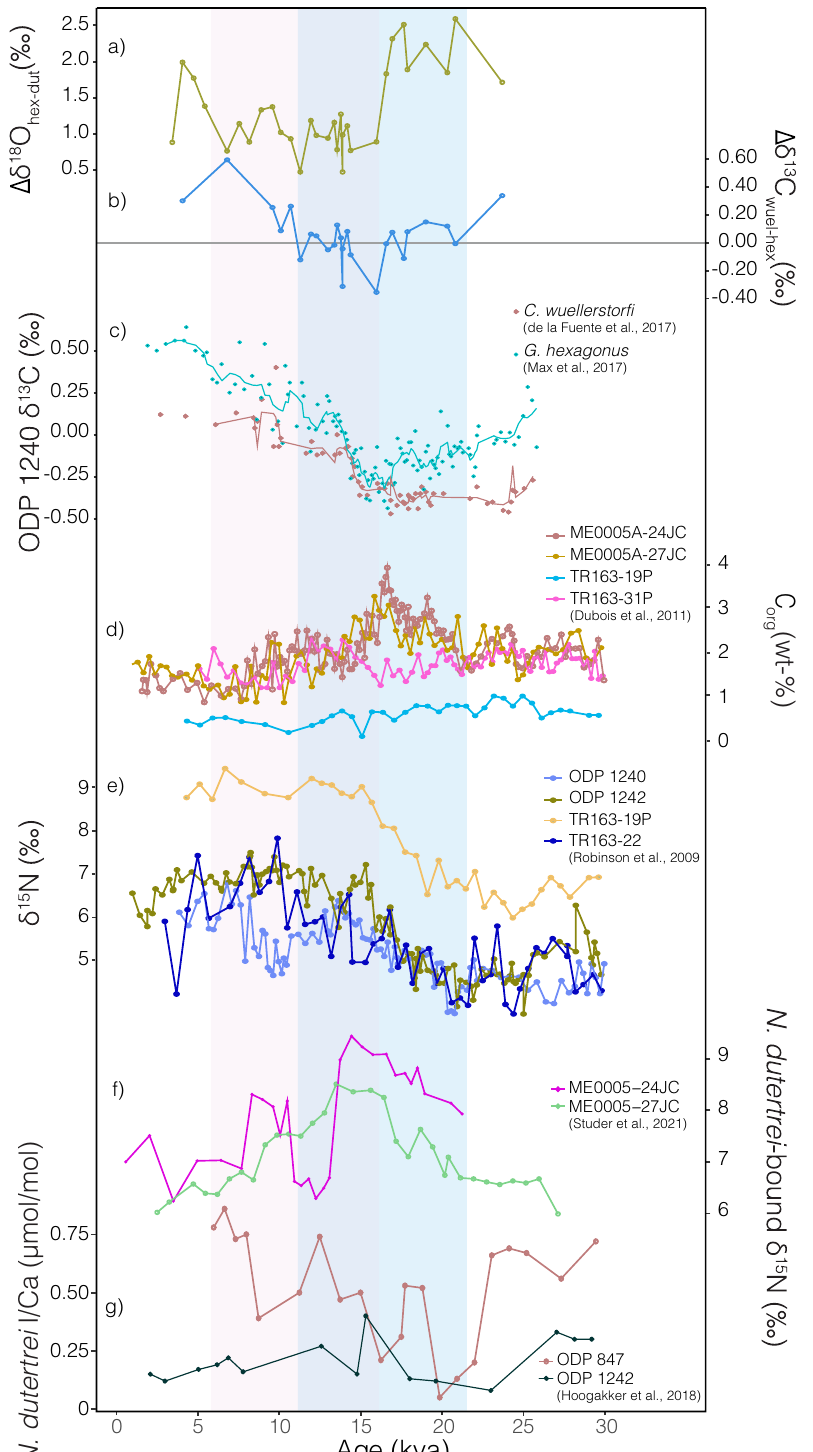
Fig. 4 A selection of representative regional records through the deglaciation. The a relative difference in δ 18 O between G. hexagonus and G. dutertrei ( Δδ 18 O hex-dut ) with the interval indicating a shoaled OMZ in red, b relative difference in δ 18 O between C. wuellerstor fi and G. hexagonus ( Δδ 18 C wuel-hex ) with the interval where that difference is near 0 in blue. The overlapping period of both shoaling and minimal δ 13 C wuel-hex is shown in purple. These records are compared with c δ 13 C records of G. hexagonus and C. wuellerstor fi from ODP 1240 20,61 shown with 5-point moving averages through each, d organic carbon records 74 , e bulk δ 15 N records 29 , f I/Ca from N. dutertrei 16 , and g N. dutertrei bound δ 15 N records from neighboring sites 60 . Propagated measurement error is 0.07 ‰ for Δδ 13 C hex-dut values in a and 0.04 ‰ for Δδ 13 C wuel-hex in b , which is smaller than the points